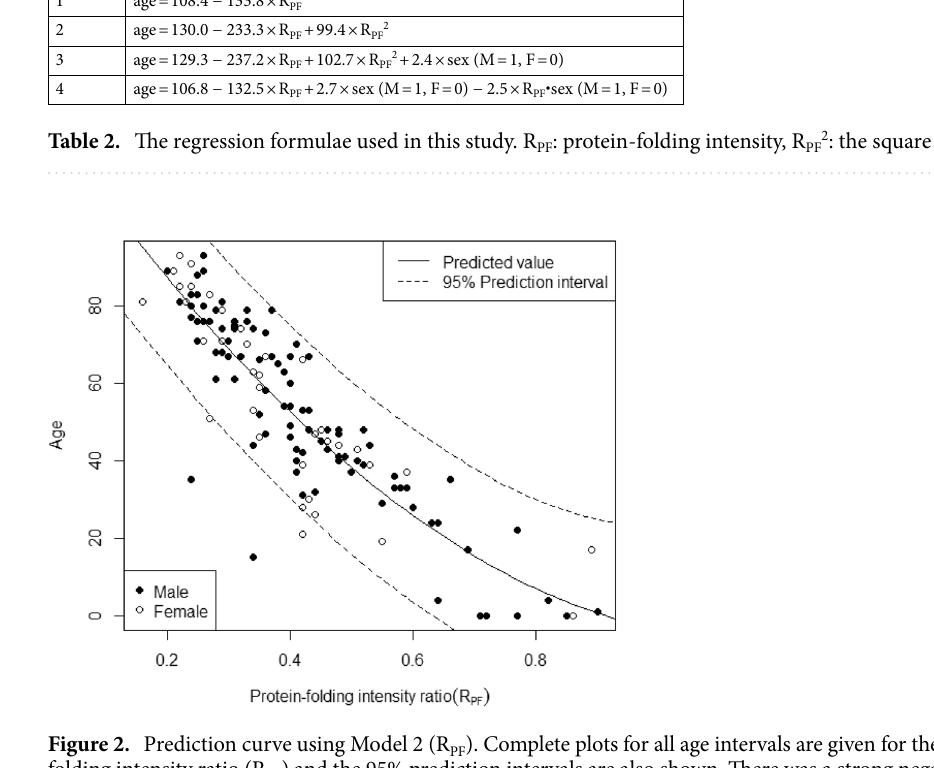
Figure 2. Prediction curve using Model 2 (R PF ). Complete plots for all age intervals are given for the protein- folding intensity ratio (R PF ) and the 95% prediction intervals are also shown. There was a strong negative correlation between age and the R PF with a Pearson correlation coefficient of r = 0.878.